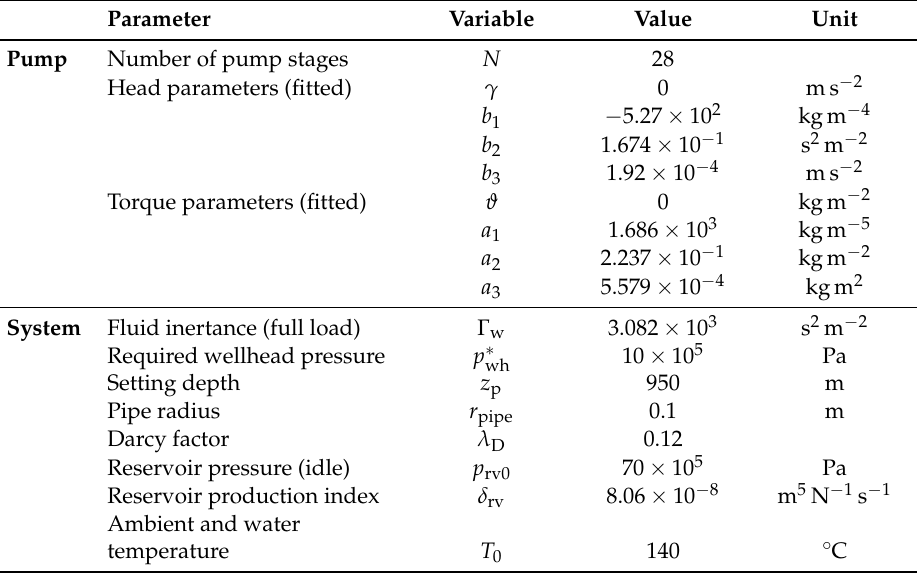
Table 4. Simulation parameters of the hydraulic